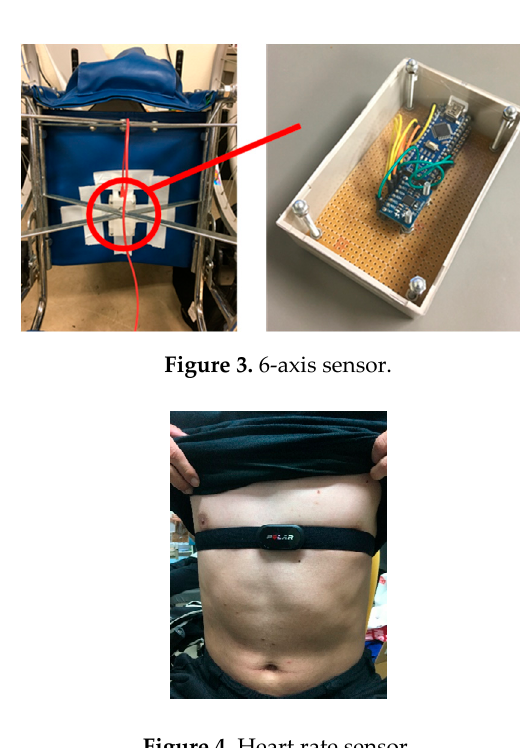
Figure 4. Heart rate